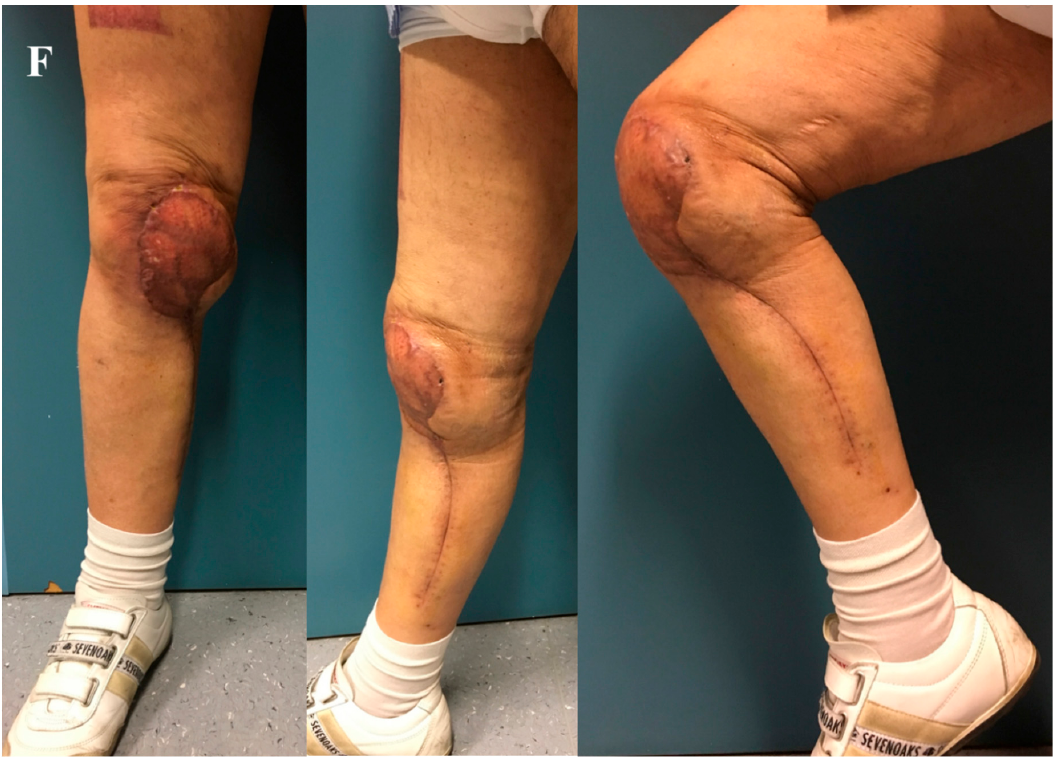
Figure 2. Wide resection for pleomorphic sarcoma of the right knee after radiotherapy and reconstruction with a pedicled medial gastrocnemius muscle flap and skin graft. ( A , B ) Preoperative planning is important to avoid basing the flap on perforator vessels located inside the irradiated field. In this case, a muscle flap from the posterior lodge was harvested. ( C ) Surgical field after wide excision of medial ligament and articular capsule; the defect resulted in the exposition of the knee joint, ( D ) requiring a stable and safe reconstruction with a muscle flap. ( E ) The area was covered by partial thickness skin grafts. ( F ) Clinical results at one-year follow-up.